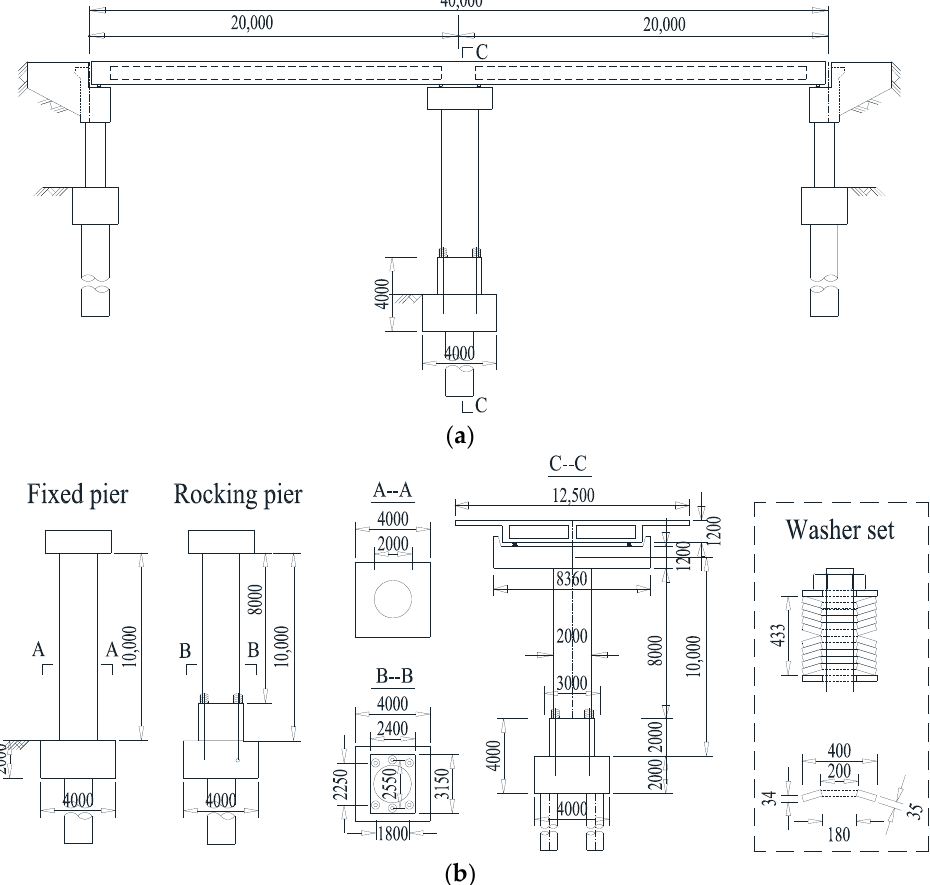
Figure 6. Geometric layout of two-span continuous concrete-girder bridge (Unit: mm): ( a ) general layout, ( b ) detailed dimensions.